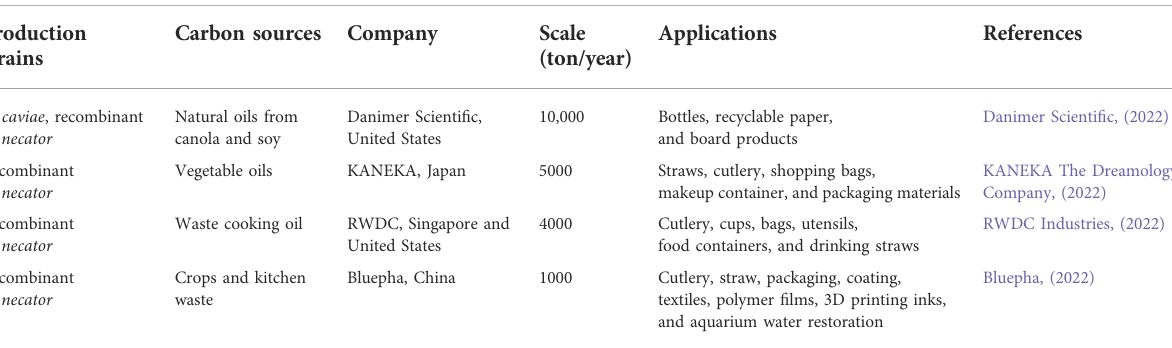
TABLE 3 Commercialized P(3HB- co -3HHx), its production strains, carbon sources, the name of company, production scale, and